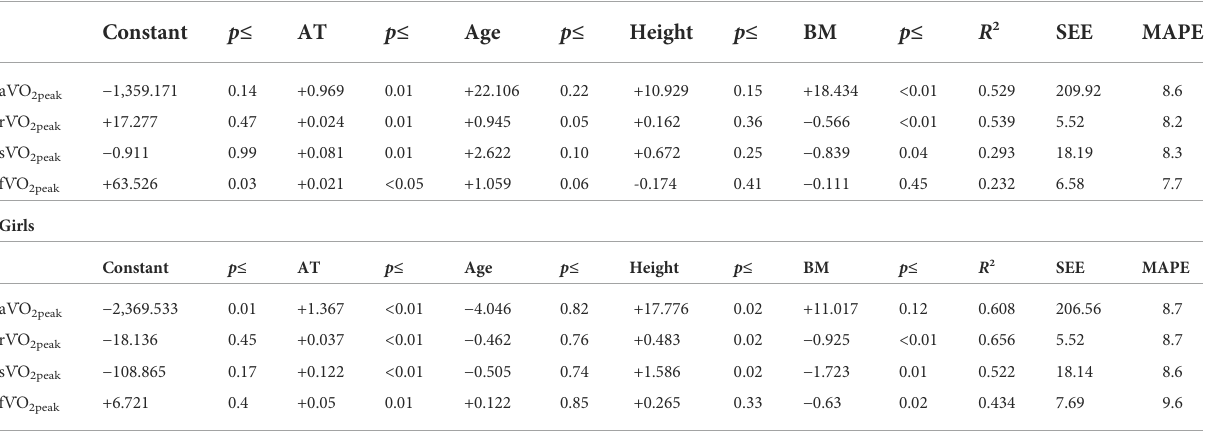
TABLE 4 Regression equations with control of maturity (age, height, and BM).